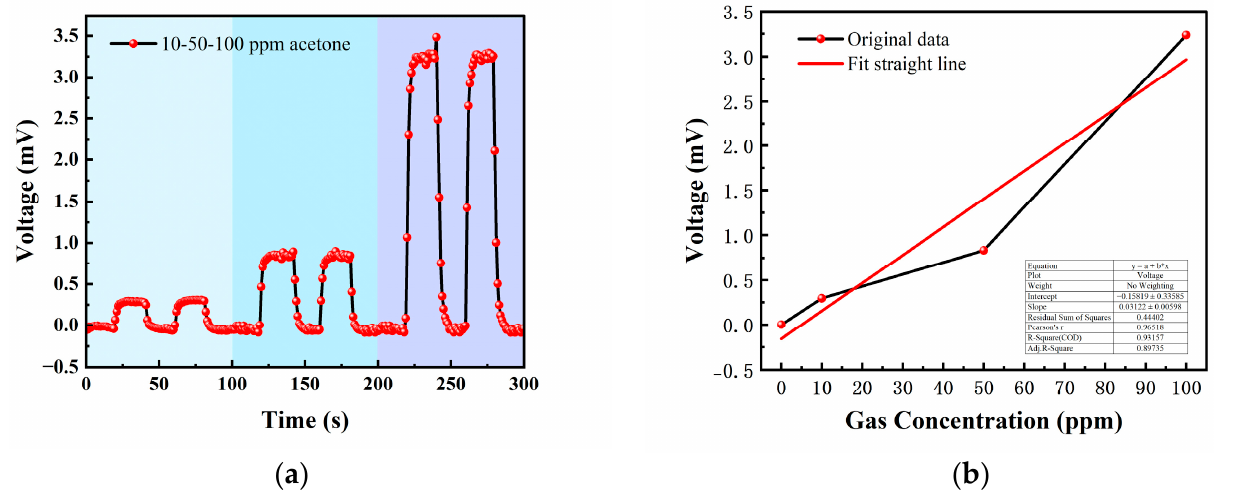
Figure 14. Different acetone gas concentration test: ( a ) 10 ppm acetone-Ar cycle test; ( b ) 50 ppm acetone-Ar cycle test; and ( c ) 100 ppm acetone-Ar cycle test.